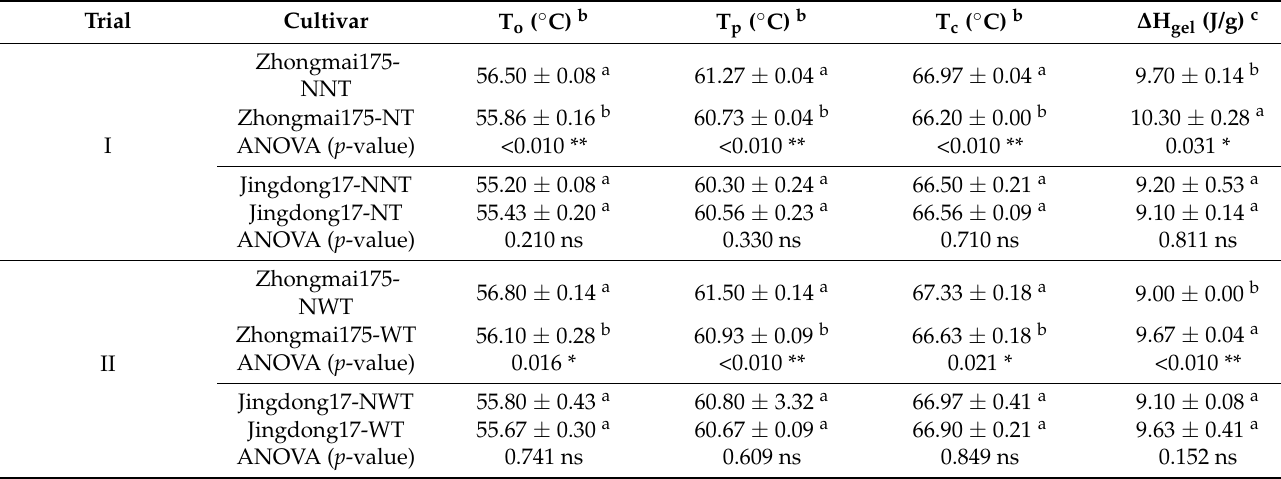
Table 2. Thermal properties of starch from Zhongmai 175 and Jingdong 17 at non-nitrogen (NNT), reduced nitrogen (NT), non-water (NWT), and reduced water (WT) treatments a,b